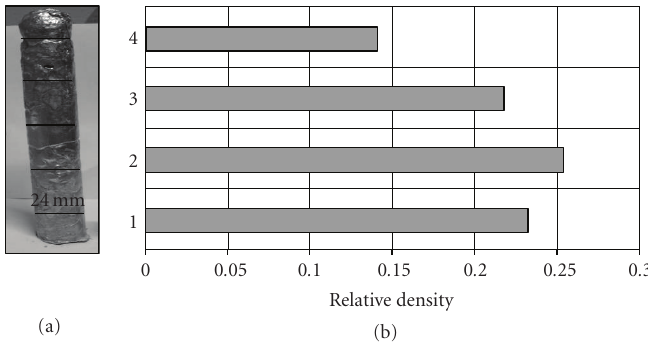
Figure 8: Relative density gradient for the sample BM, air, suction sectioned in four slices.